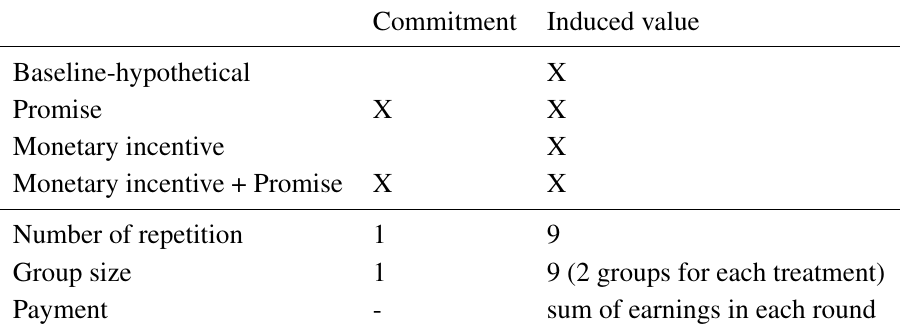
Table 2: Experimental